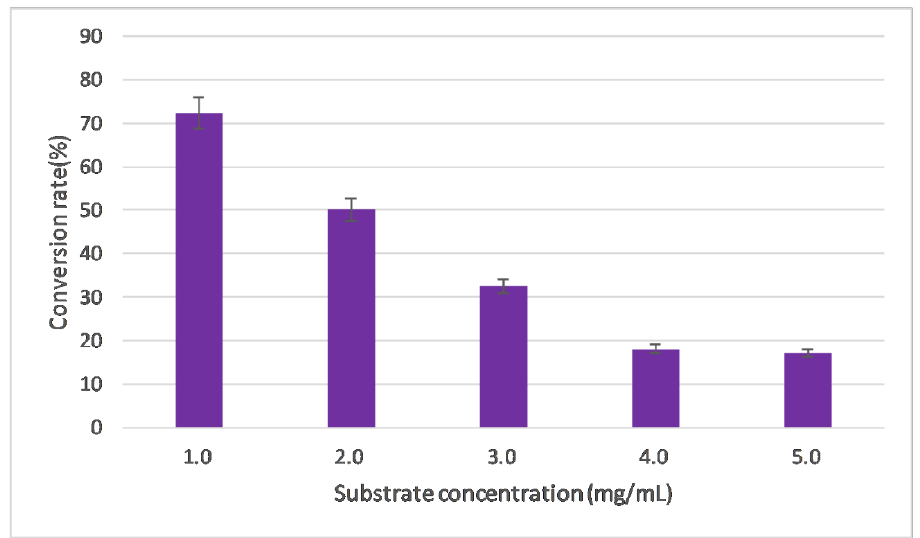
Figure 8. Effects of substrate concentration on metabolite conversion rate (initial pH = 6.5, culture time 5 d, media volume 50 mL, substrate concentration 1 mg/mL).